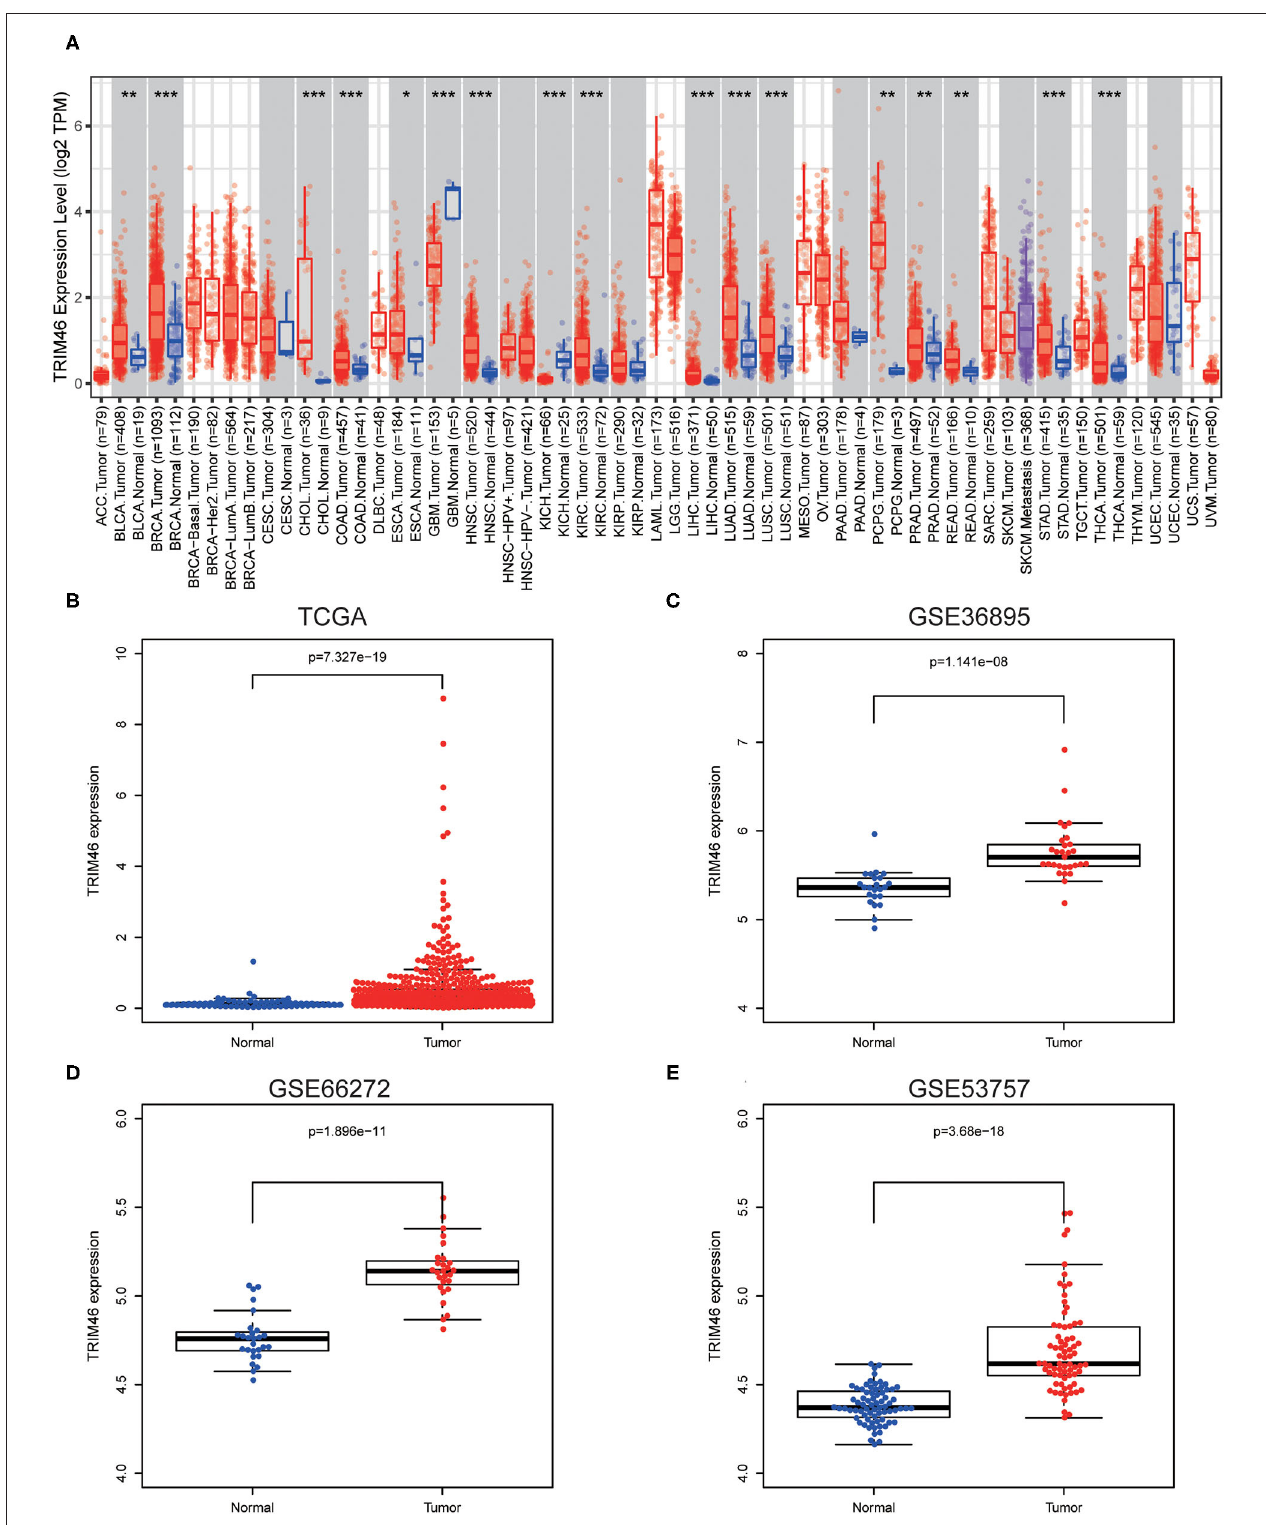
FIGURE 1 | The distinct upregulation of tripartite motif containing 46 (TRIM46) in clear cell renal cell carcinoma (ccRCC) specimens. (A) TRIM46 expressions in several types of tumors via analyzing TCGA datasets were confirmed by the use of TIMER. (B–E) The overexpression of TRIM46 was demonstrated via analyzing data from TCGA, GSE36895, GSE66272, and GSE53757. * p < 0.05, ** p < 0.01, *** p < 0.001.